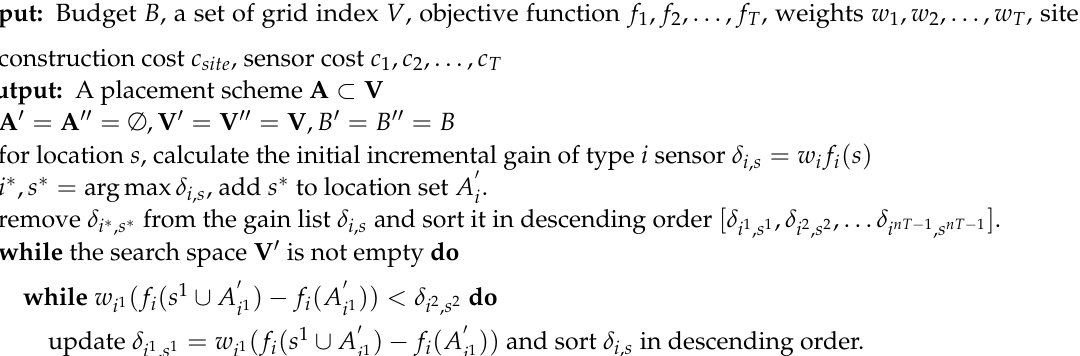
Algorithm 4 Lazy greedy algorithm for the general cost